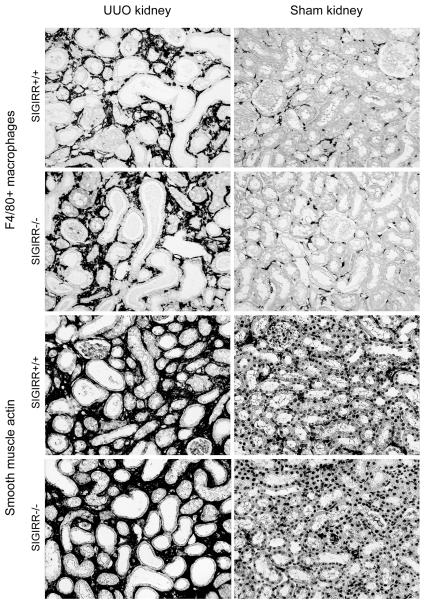
Macrophages and myofibroblasts in the postobstructive kidney.Cortical renal sections were either stained with F4/80 or SMA. Images illustrate representative sections of UUO and sham-operated kidneys 10 days after UUO in mice of the respective group as indicated (original magnification 200×).